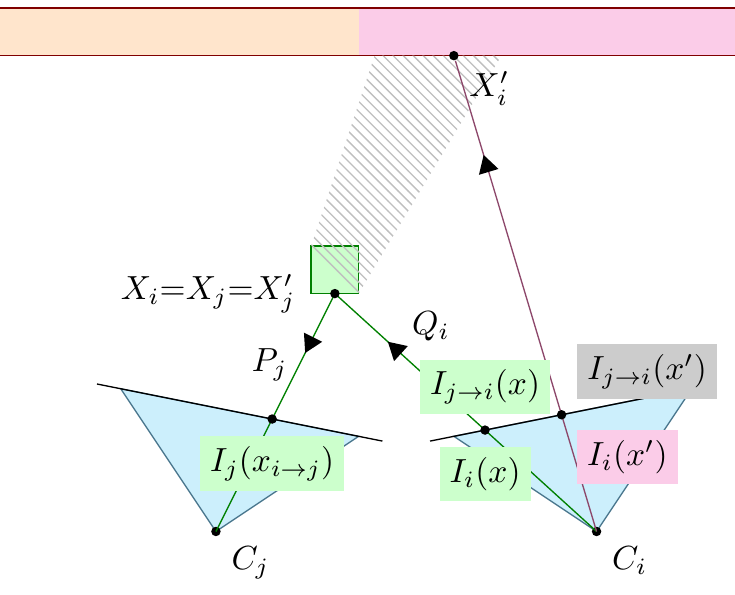
Figure 2. Reprojection from viewpoint j to i ; the foreground object (green) produces an occlusion (in black) of the background